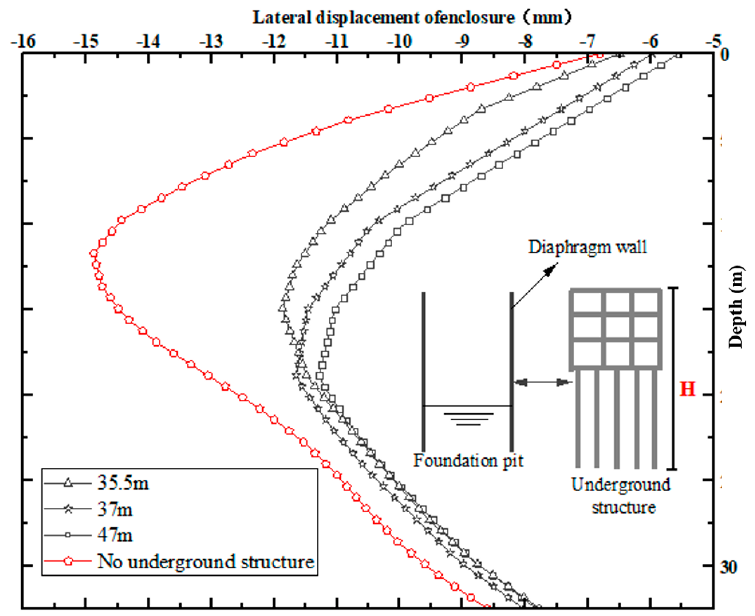
Figure 8. Distribution of lateral displacement of enclosure under different H .